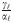
The effect of different HDL actions on equilibrium foam cell density.Plots showing where equilibrium plaques with a fixed density of foam cells exist as a function of σh the rate of influx of HDL and (a) σm which governs the rate of influx of monocytes and may be thought of as the availability of monocytes in the blood stream; (b) γℓαℓ which governs the rate that LDL is modified and hence the rate that modLDL enters the model plaque; and (c) γmαm which governs the excitability of the endothelium in response to modLDL and its propensity to express adhesion molecules and thereby recruit macrophages to enter the lesion. In each plot, the curve is the locus of the bifurcation point.